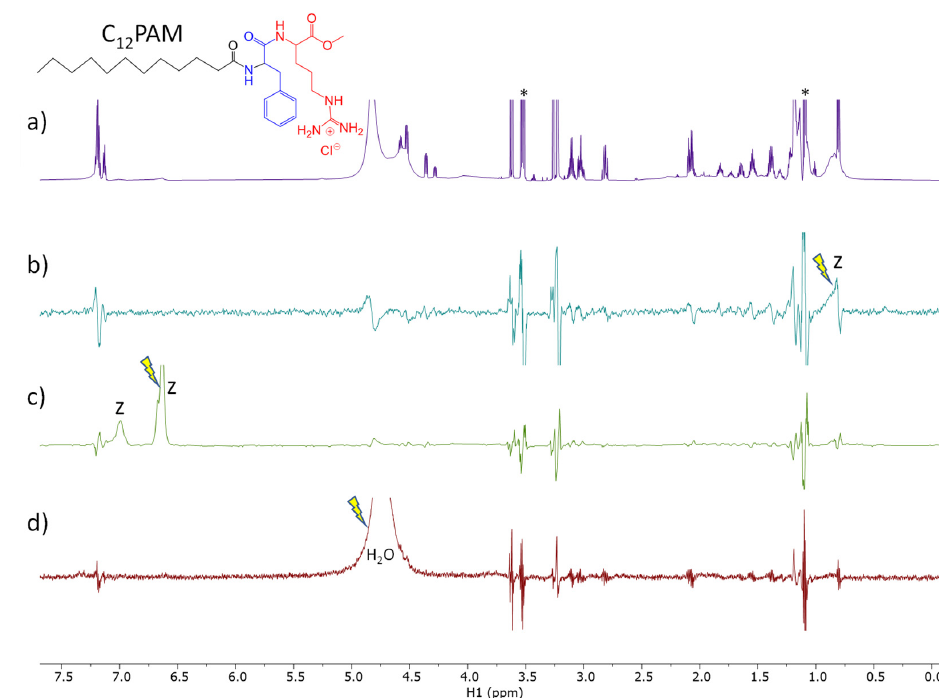
Figure 8. Spectra of PANHC 12 and zein mixture. ( a ) 1 H NMR, ( b , c ) STD off-on spectra with saturation at 0.82 and 6.6 ppm, respectively and ( d ) WaterLOGSY (mix. 500 ms). The arrow indicates the signal that is selectively on-saturated in STD spectra or selectively inverted in WaterLOGSY. The assignment is provided for some relevant protons giving STD or WaterLOGSY responses. The z refers to zein peaks and the asterisk denotes protons of ethanol impurity.